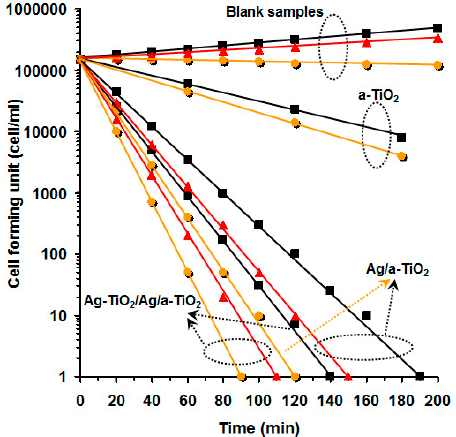
Figure 6. Killing of E. coli exposed to a-TiO 2 , Ag/a-TiO 2 and Ag-TiO 2 /Ag/a-TiO 2 photocatalyst thin films as compared to blank (control) sample, in dark ( █ ) or irradiated with visible light ( ▲ ) or solar light ( ● ) [52].